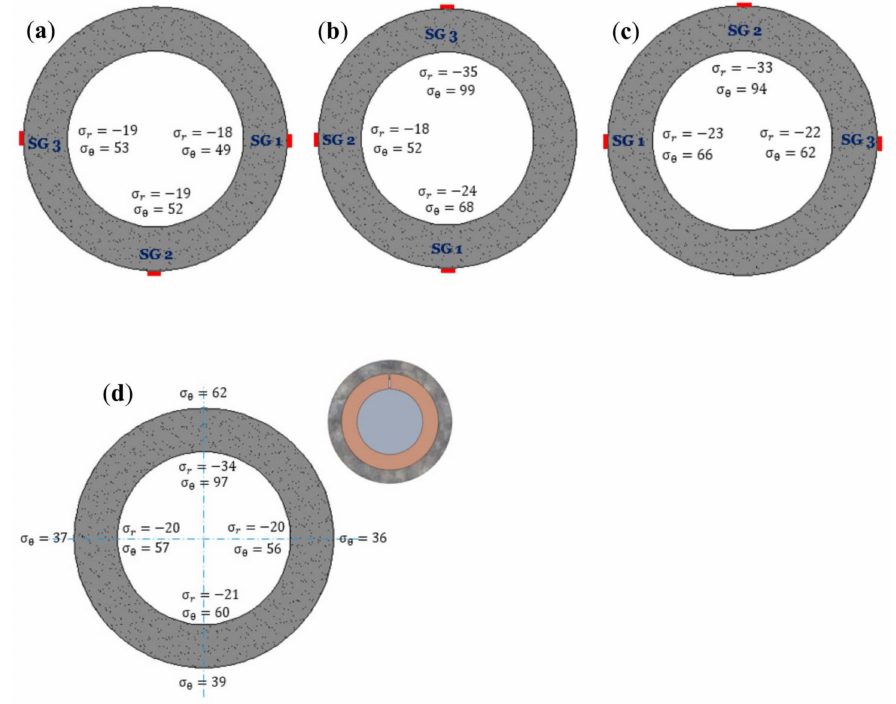
Figure 5. Non-lubricated sleeve with sleeve complete cut-through at π /2 (stresses in MPa). ( a ) Test 1 ( b ) Test 2 ( c ) Test 3 ( d ) Average value of the three